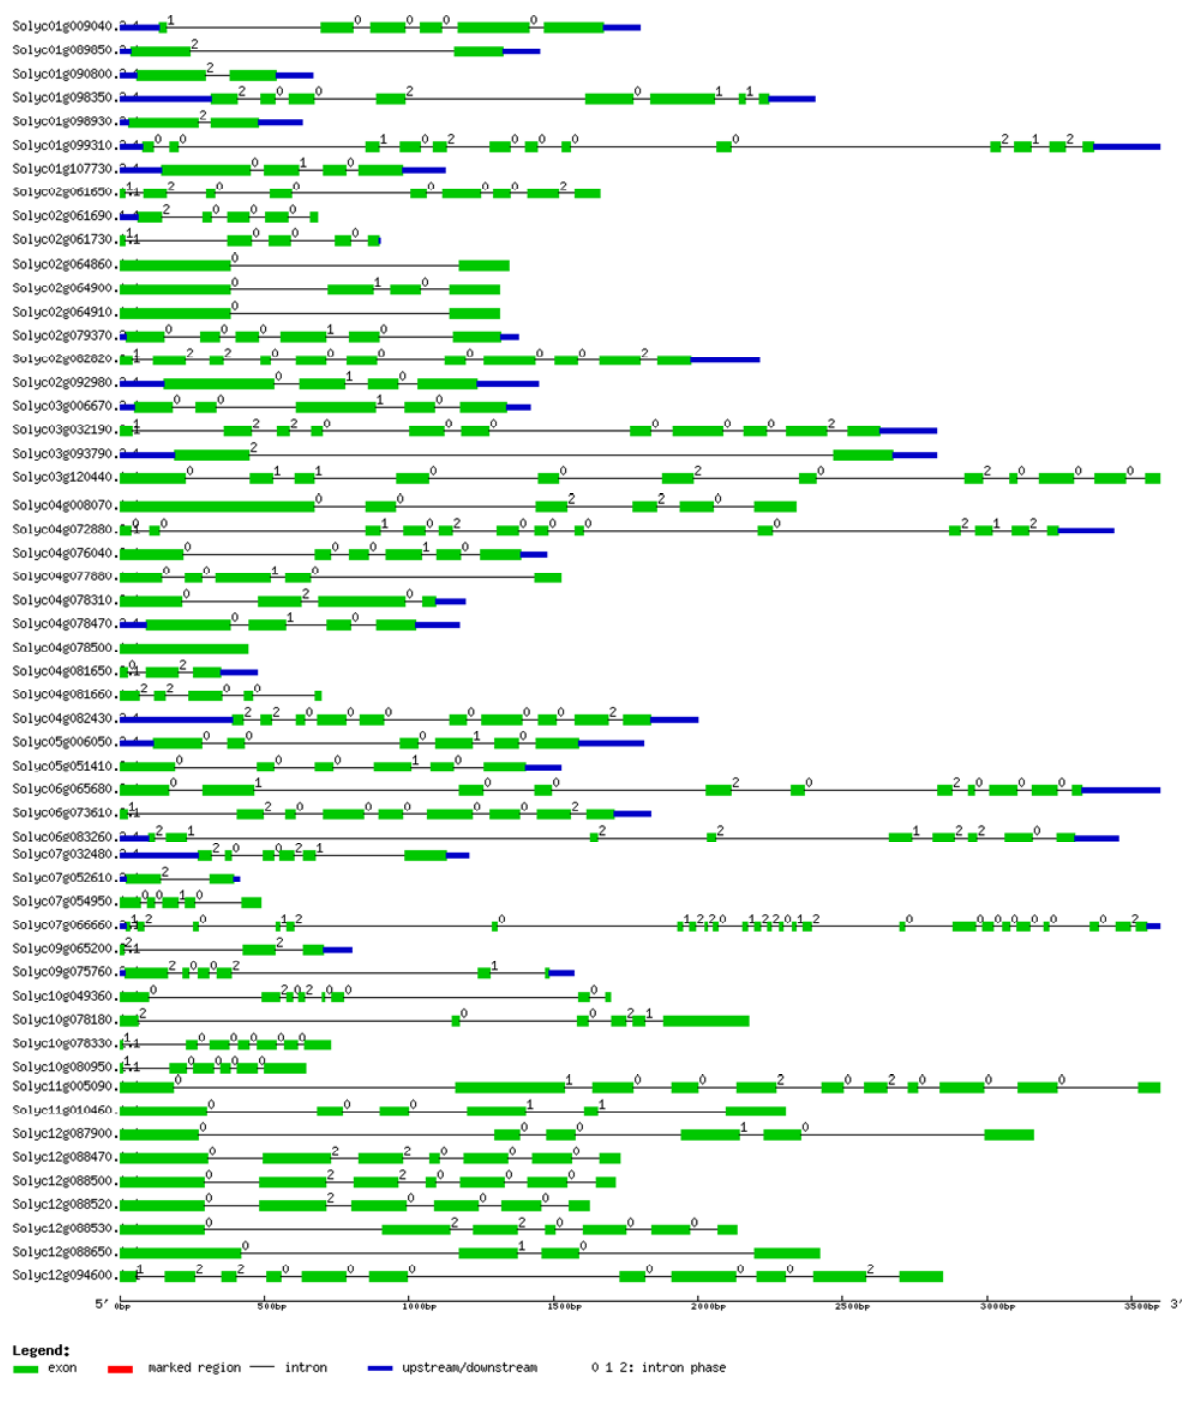
Figure 3. Gene structure of tomato cyclins generated from